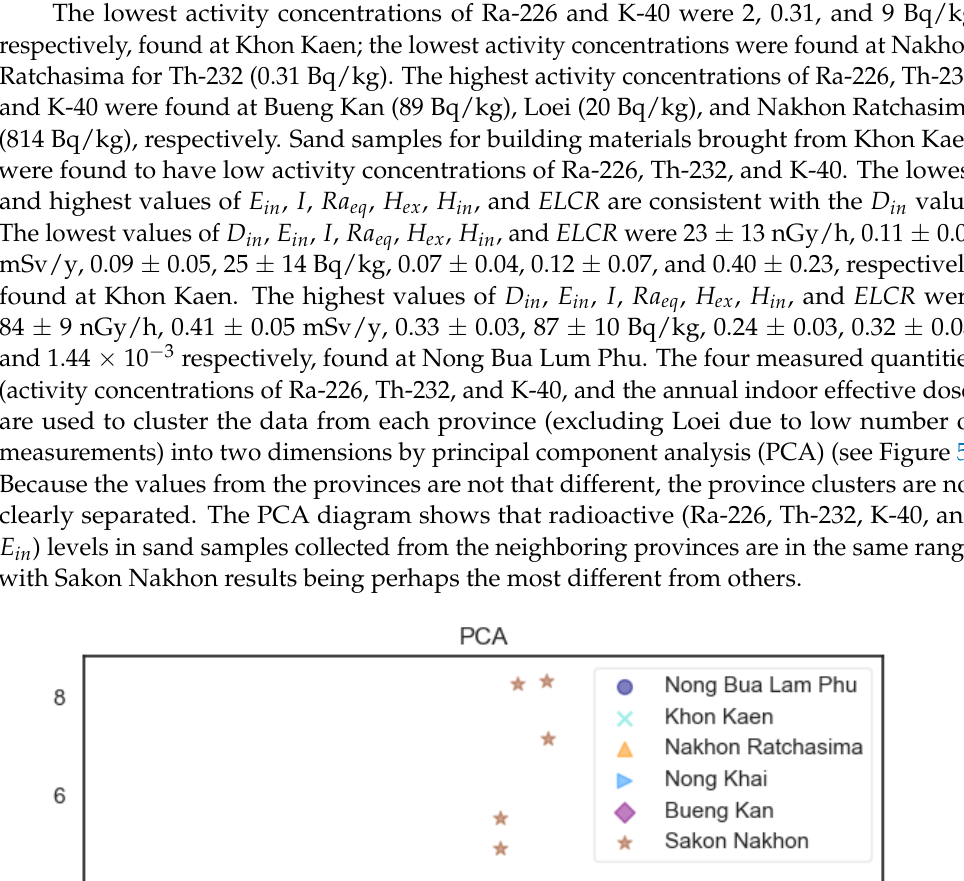
world averages are 35, 30, and 400 Bq/kg, and 51 nGy/h for Ra-226, Th-232, K-40, and the